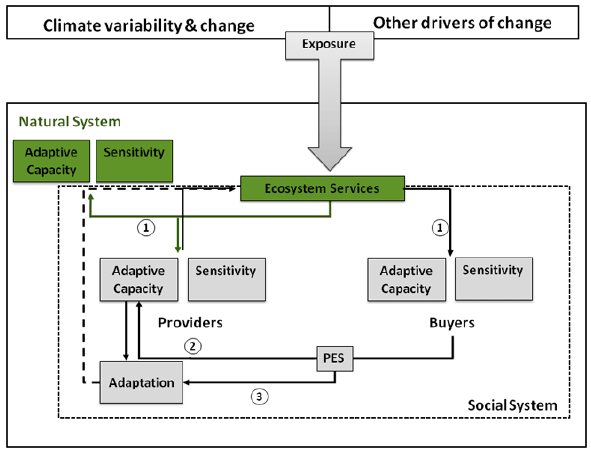
Fig. 1 . Framework showing the link between payments for ecosystem services (PES), adaptation, and vulnerability of the coupled social-ecological system. Source: based on van de Sand (2012 a